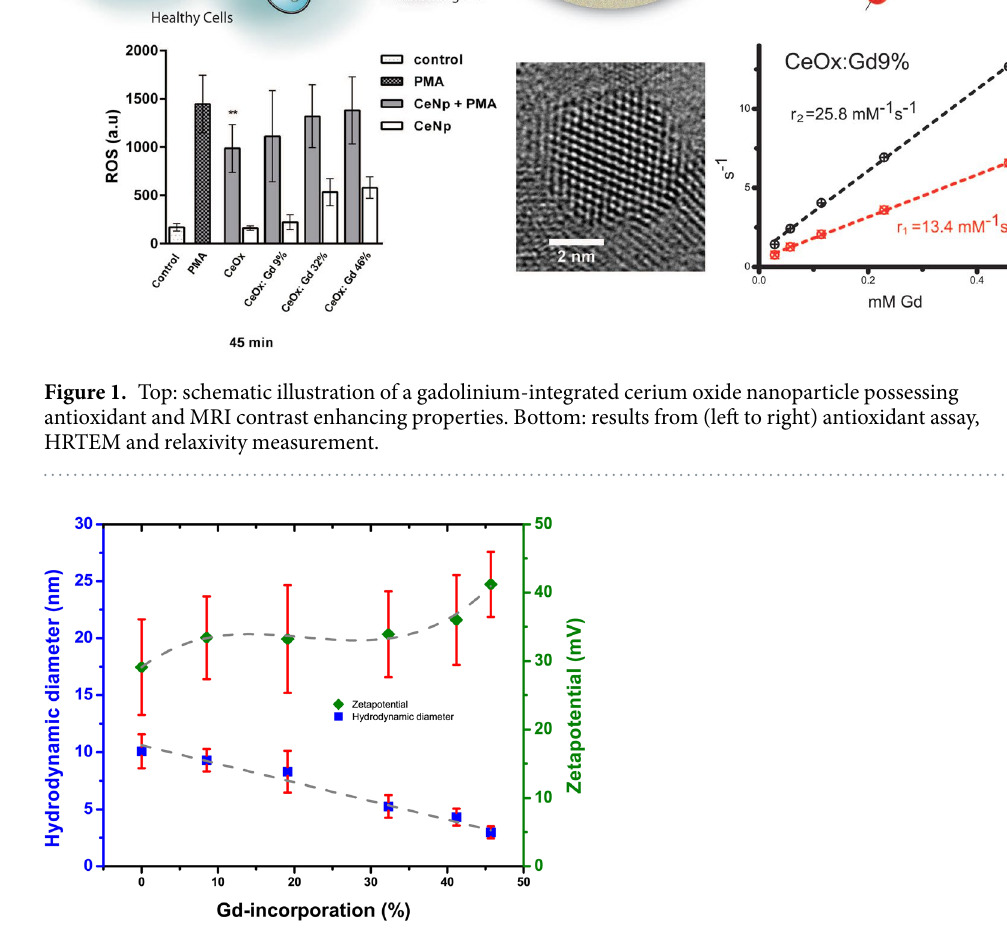
Figure 2. Contin number weighted hydrodynamic diameter and Zeta potential values for CeNPs with fractions of gadolinium 0%, 9%, 19%, 32%, 41% and 46% (CeOx, CeOx:Gd9%, CeOx:Gd19%, CeOx:Gd32%, CeOx:Gd41% and